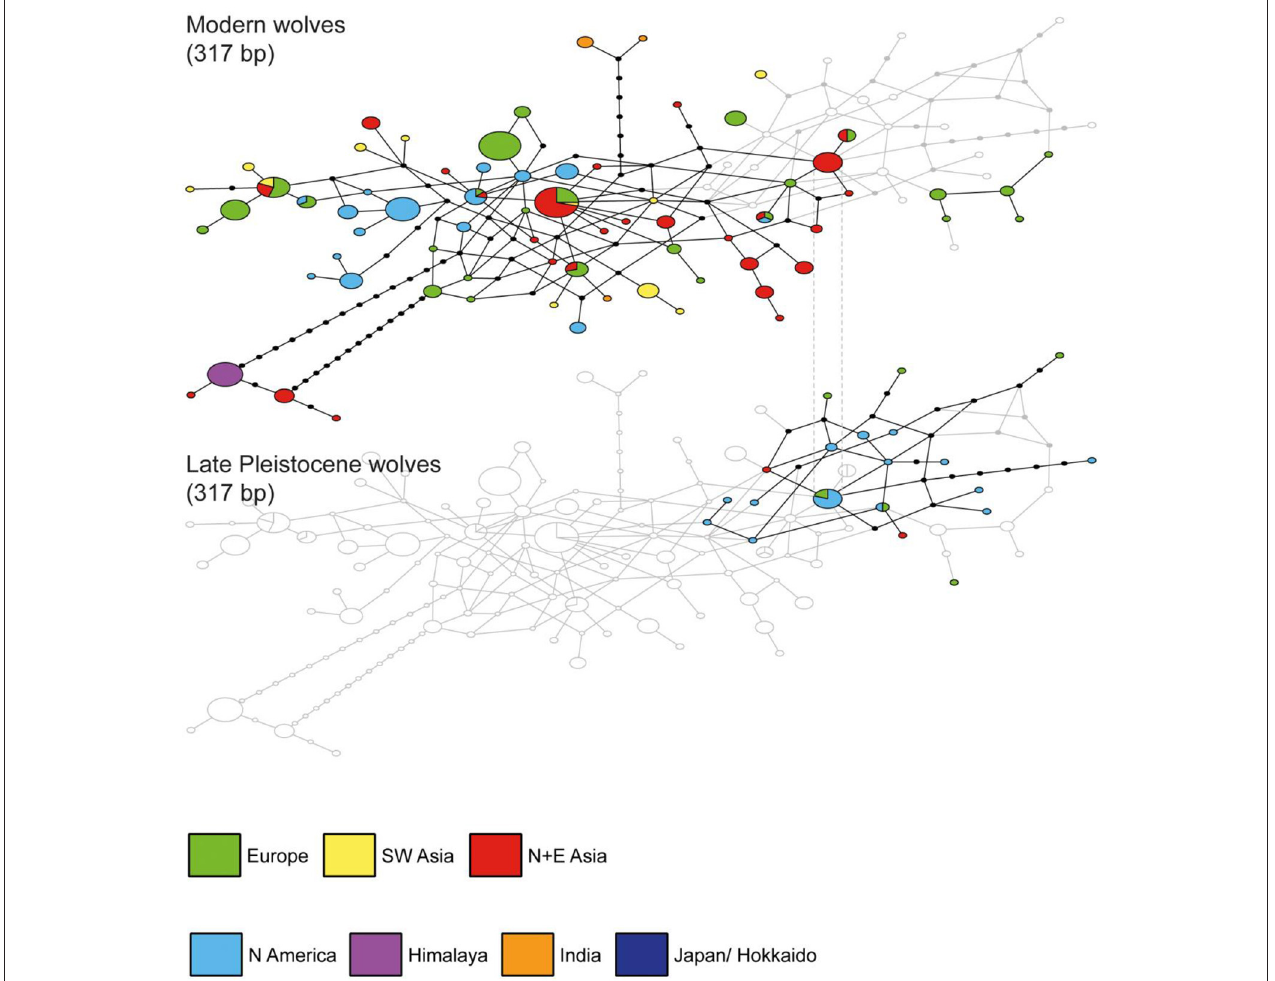
FIGURE 2 | Median joining network analysis for wolf haplotypes based on alignment B excluding indels (317 bp) and including a temporal comparison (Late Pleistocene vs. modern). Haplotypes (ellipses) are separated by the number of mutational steps indicated by continuous lines and black ellipses represent missing